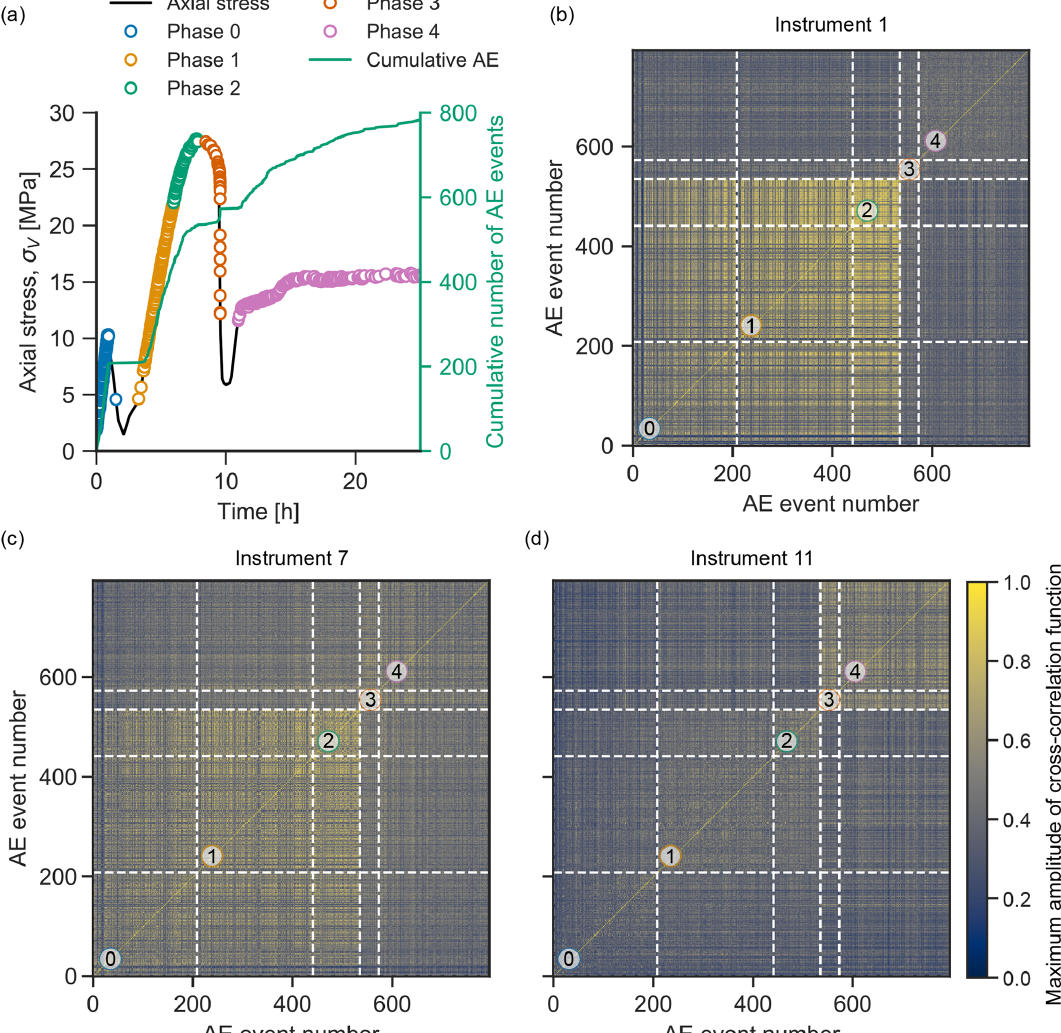
Figure 4. Cross-correlation of AE waveforms. (a) A subset of 795 AE events, located along the stress-time curve and split into 5 phases. (b, c, d) Peak amplitudes of the normalised cross-correlation function between waveforms recorded at sensors 1 (b) , 7 (c) and 11 ( d , see Fig. 3 for sensor